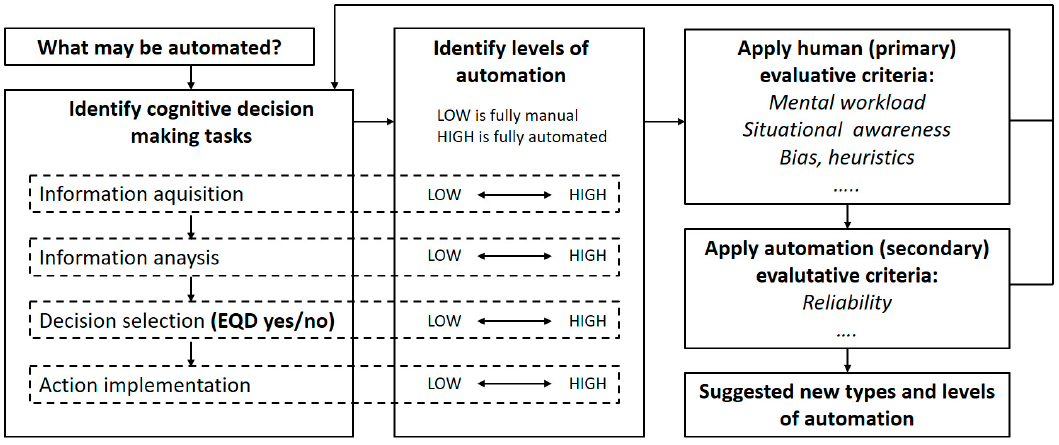
Figure 4. Our research framework for identifying and improving the level of automation in EQD.